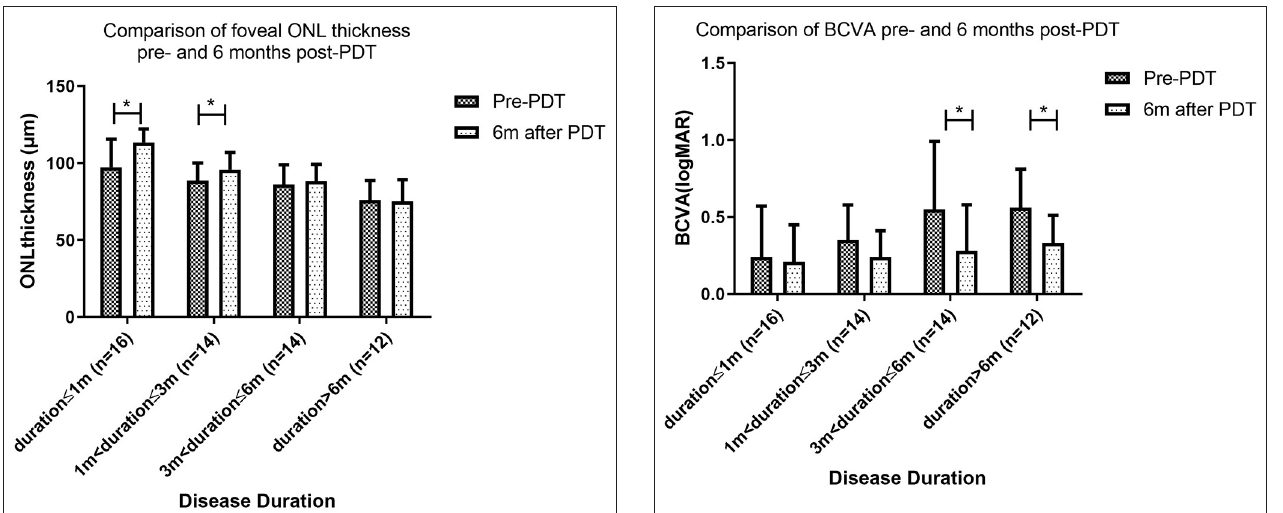
the BCVA in his right eye was 20/20. SD-OCT showed serous retinal detachment at the macula and the foveal ONL thickness was 102 µ m. He was diagnosed with CSC in the right eye and chose to be treated with half-dose PDT immediately. One month